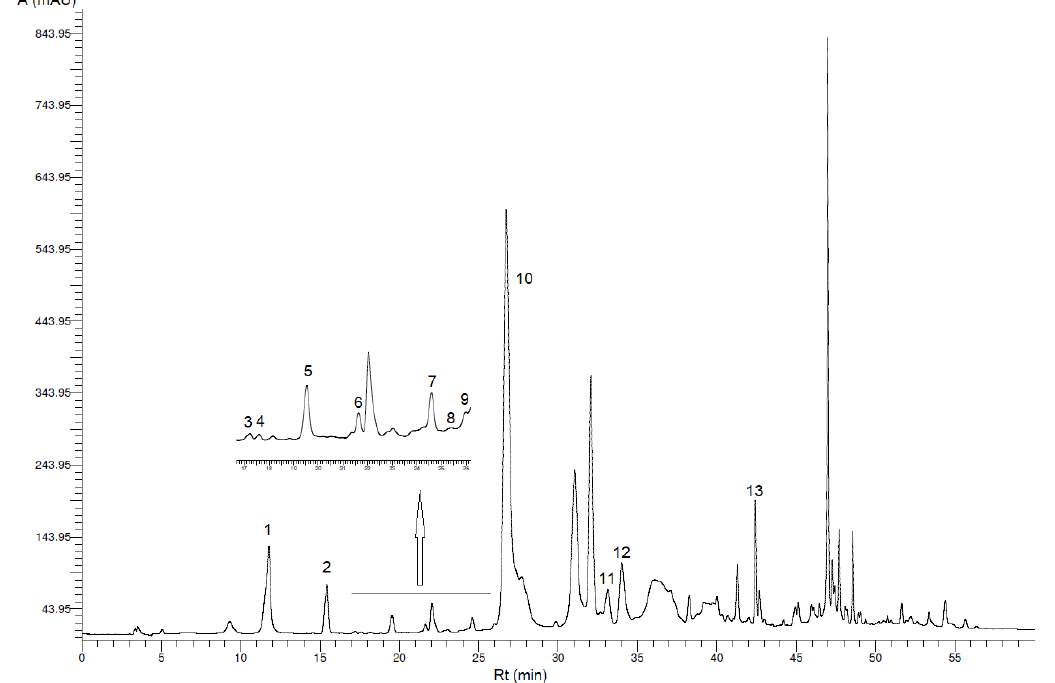
Table 1 (A—absorbance, R t —retention